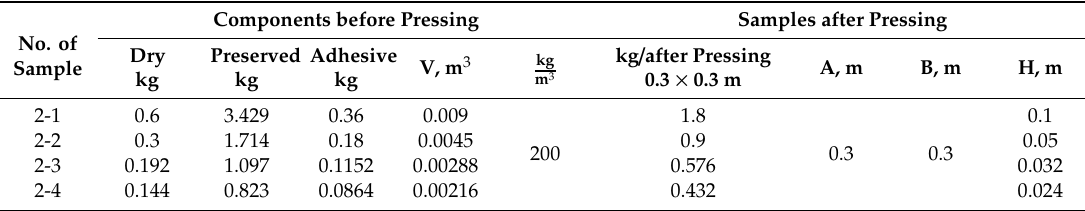
Table 2. Components of samples from the second series.